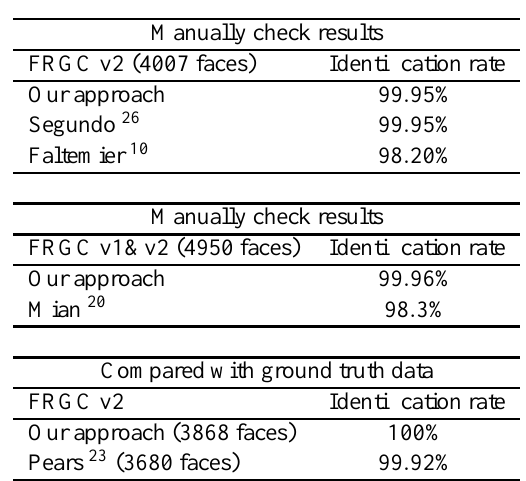
Table 1. Details in comparison with state-of-the-art